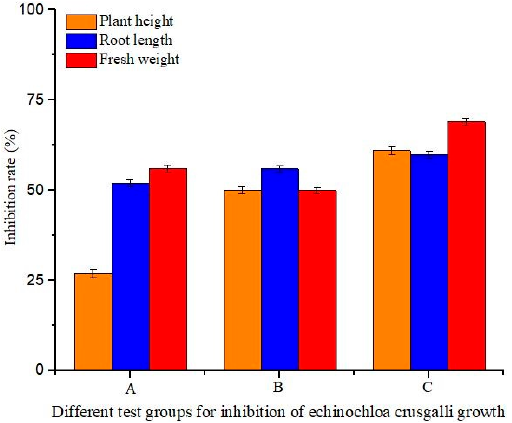
Figure 11. Result of the biological activity assay: ( A ) diuron; ( B ) physical mixture; and ( C ) the inclusion complex.